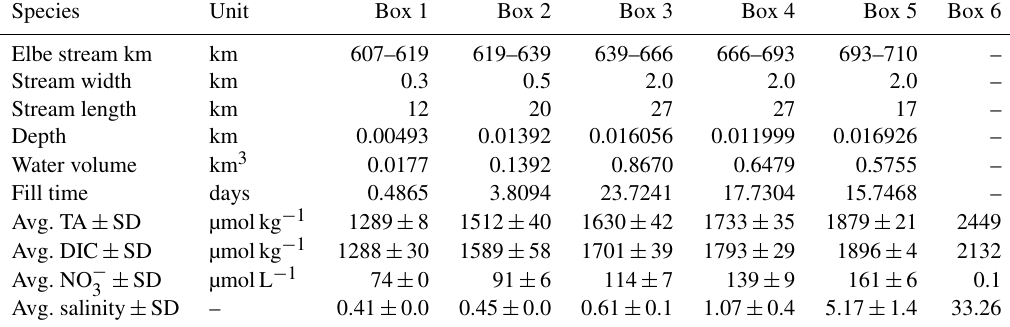
Table 1. Elbe Estuary data for the mass balance calculation. The water depths were from an acoustic Doppler current profiler (ADCP) on board of RV Ludwig Prandtl , and the river length is based on the Elbe stream kilometer. The river width is based on measurements with Google Maps ® , while a standardized river width of 2km was used for boxes 3, 4, and 5. The average river discharge on our sampling days was 423m 3 s − 1 (provided by FGG, 2021) measured at the last tide-free long-term sampling station in Neu Darchau (Elbe stream km 536). Average box values are given for total alkalinity (TA), dissolved inorganic carbon (DIC), nitrate (NO − ), and salinity. For the outer 3 boundary conditions (box 6), we used a maximum salinity of 33.26, and respective TA (2449µmolkg − 1 ), DIC (2132µmolkg − 1 ), and NO − 3 (0.1µmolL − 1 ) values were taken on cruise HE541 (54.062456 ◦ N, 8.015919 ◦ E), which took place 2 months later in September 2019 and represent average summertime values for the German Bight. Standard deviation ± SD as spatial variability is given when possible. Species Unit Box 1 Box 2 Box